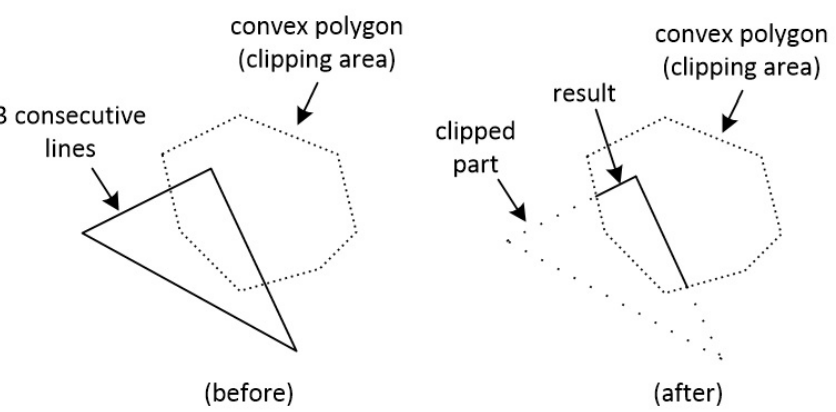
Figure 27. Clipping three consecutive lines that form a triangle against a convex polygon. The result is clipped